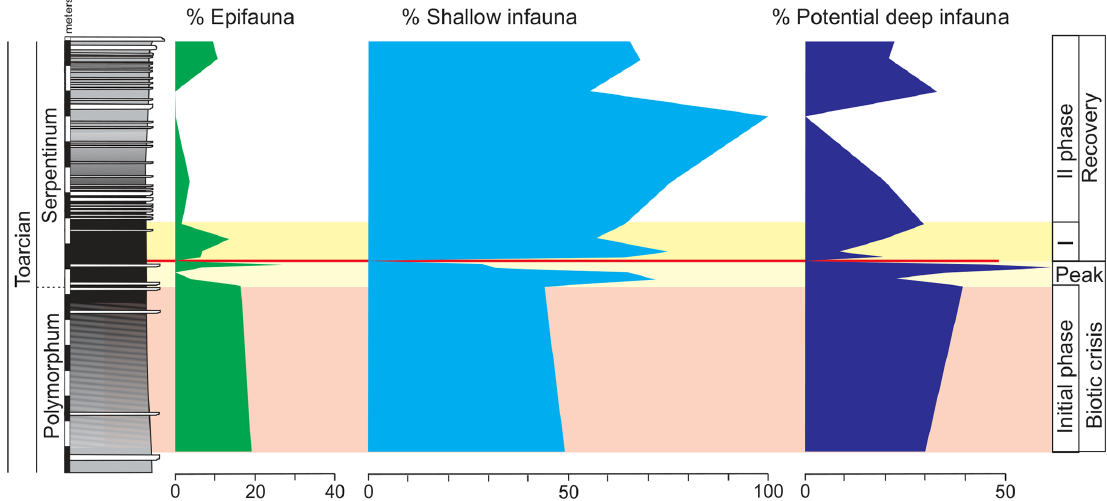
Figure 10. Stratigraphic distribution of the proportions of foraminifera according to lifestyle assigned in the morphogroups (see Fig.